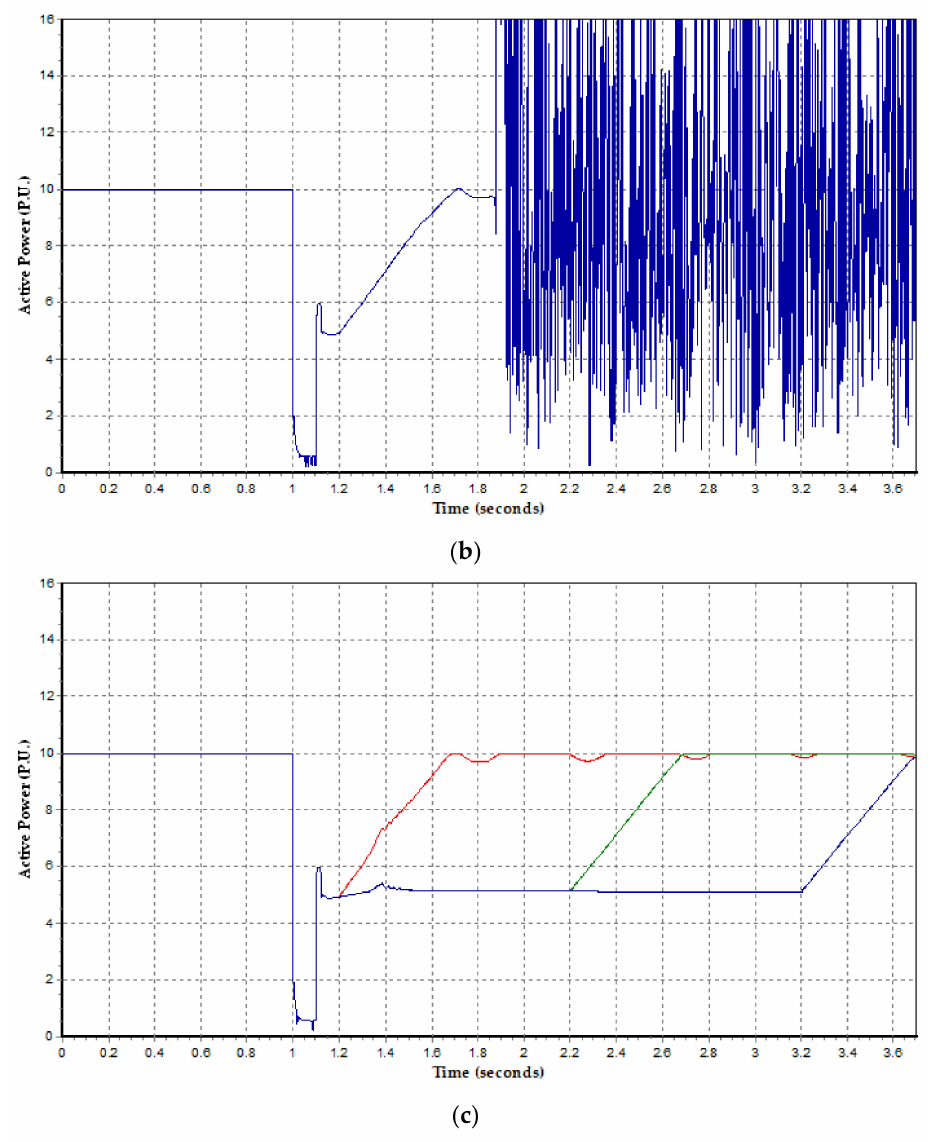
Figure 9. ( a ) Non-convergence problem after fault removal; ( b ) recovery of the active power via adjusting simulation parameters; ( c ) active power recovery through dynamic parameter